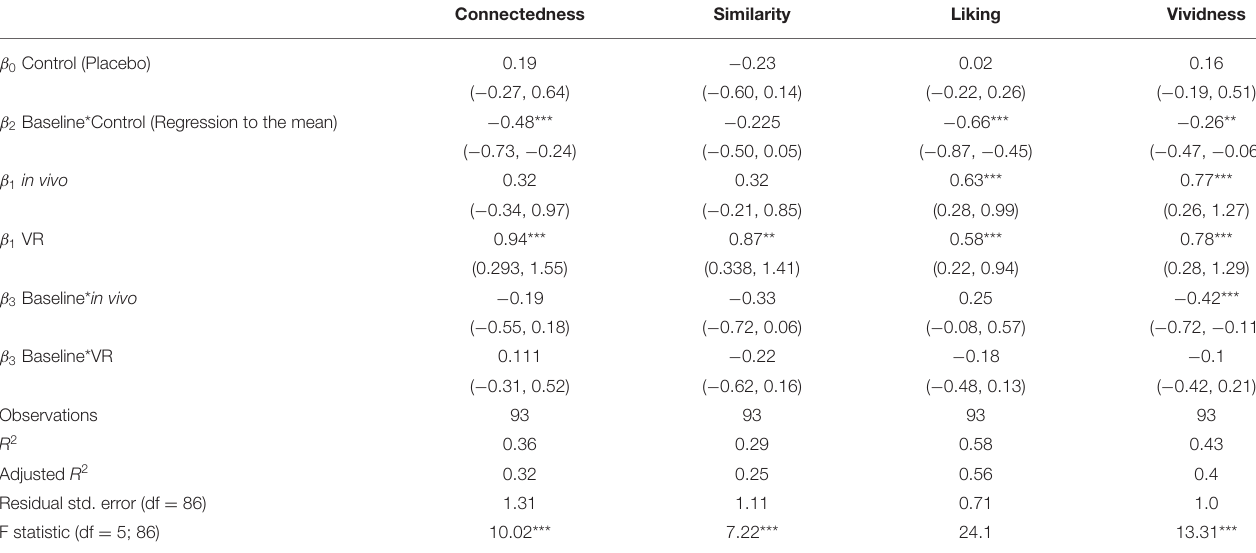
TABLE 2 | Regression coefficients and 95% confidence intervals of control, in vivo , VR, and baseline interactions on difference scores of the domains of future self-continuity.